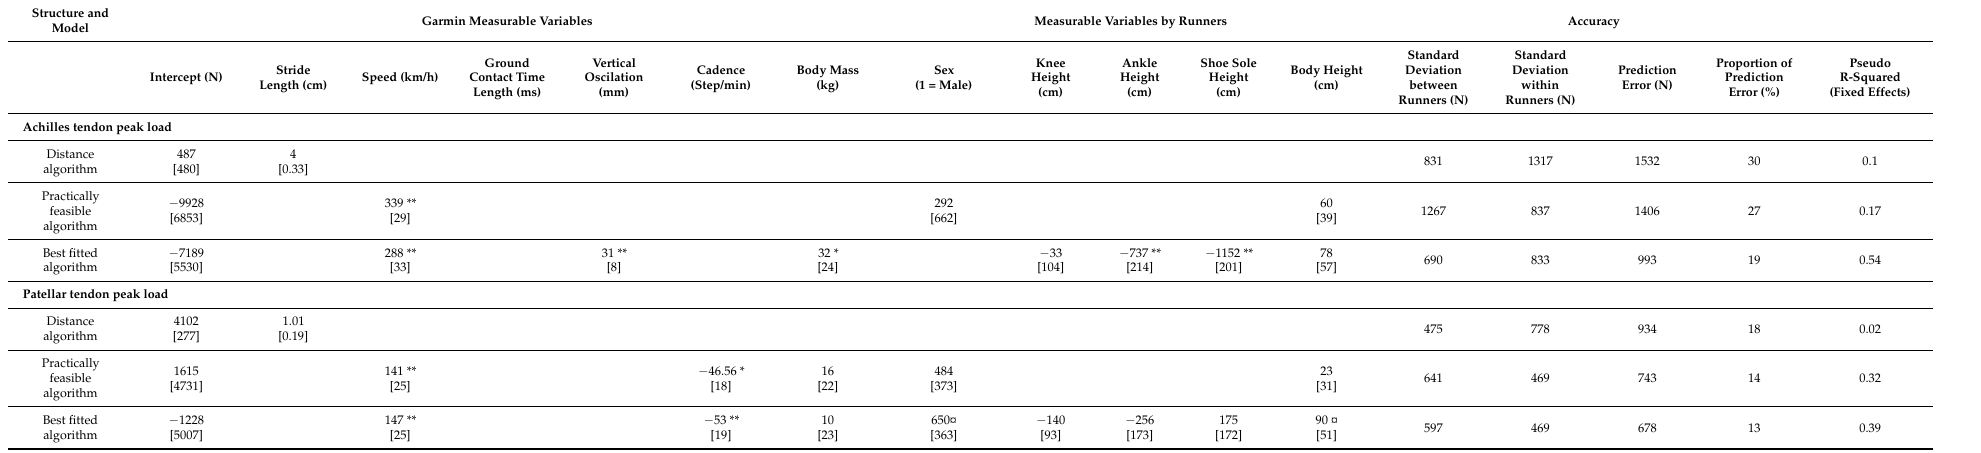
Table 1. The predictive algorithms of the patellar and Achilles tendon peak force during running based on outdoor measurable features.